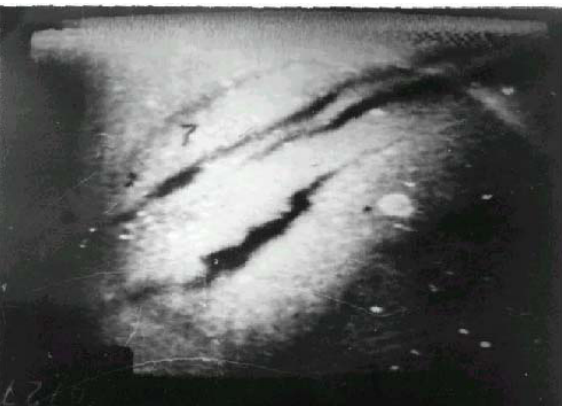
Fig. 15. Black aurora from low light level TV